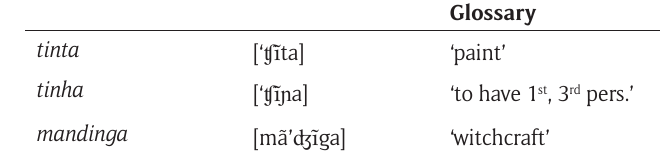
Table 6: Palatalization of /t/, /d/ preceding the nasal vowel [ ĩ ].